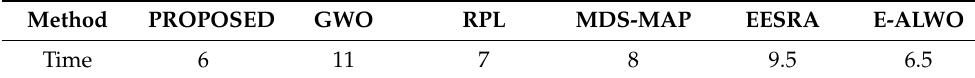
Table 7. A comparison of the computational times of various protocols.